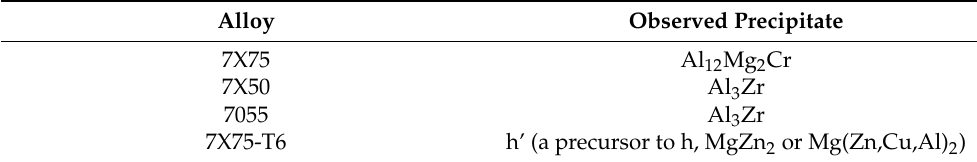
Table 4. Observed precipitates in aircraft Al alloy products [42,119,122]